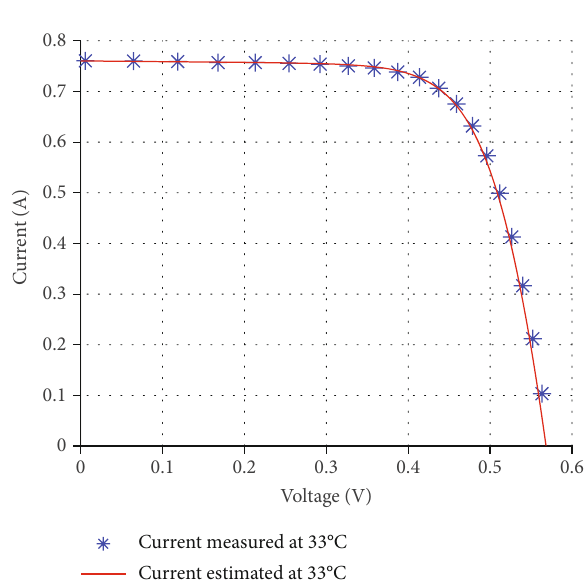
Figure 4: Estimated and measured current curves for the single diode model.